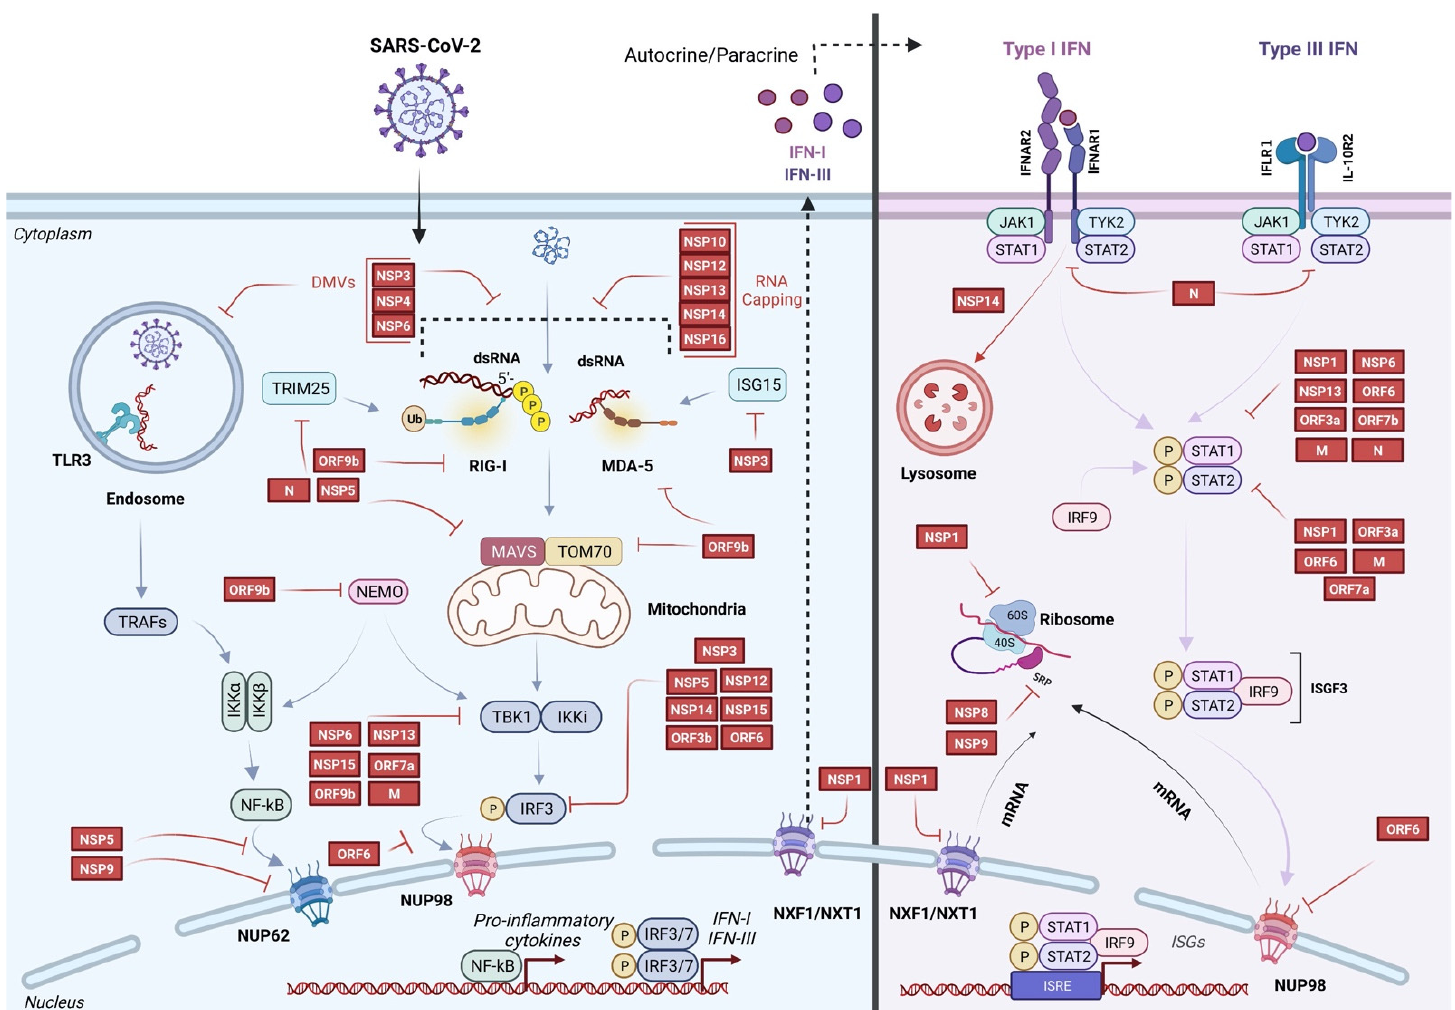
Figure 1. Model describing the pathways targeted by SARS-CoV-2 to antagonize the innate immune response.